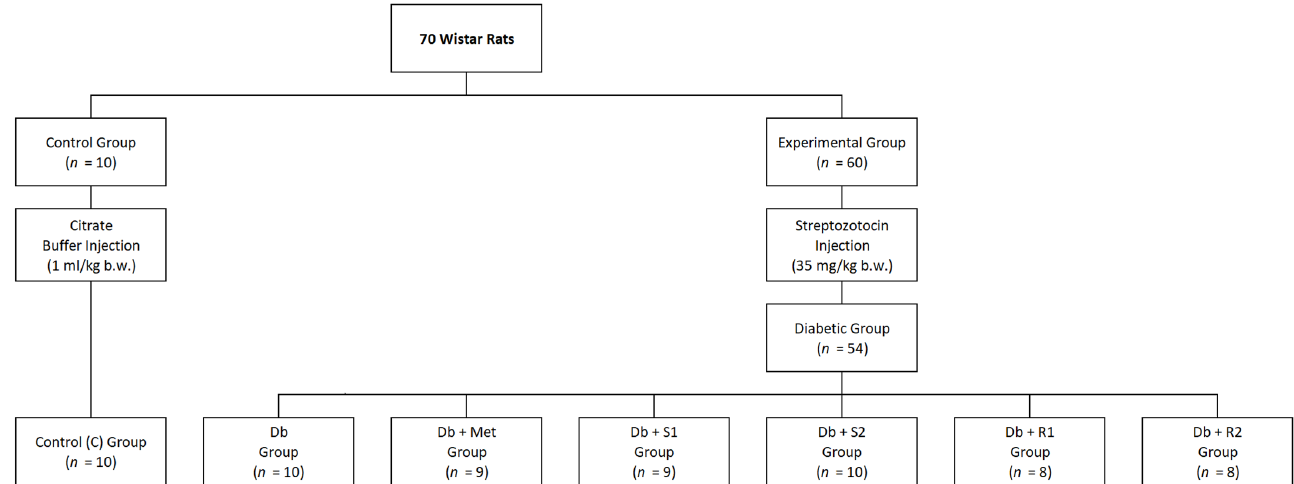
Figure 1. The allocation of rats to individual groups. Control group (C): healthy rats receiving AIN-93M diet, Db group: diabetic rats receiving high-fat (HF) diet, Db + metformin (Met) group: diabetic rats receiving HF diet with 0.15% metformin, Db + S1 group: diabetic rats receiving HF diet with 0.5% stevioside, Db + S2 group: diabetic rats receiving HF diet with 2.5% stevioside, Db + R1 group: diabetic rats receiving HF diet with 0.5% rebaudioside A, Db + R2 group: diabetic rats receiving HF diet with 2.5% rebaudioside A.